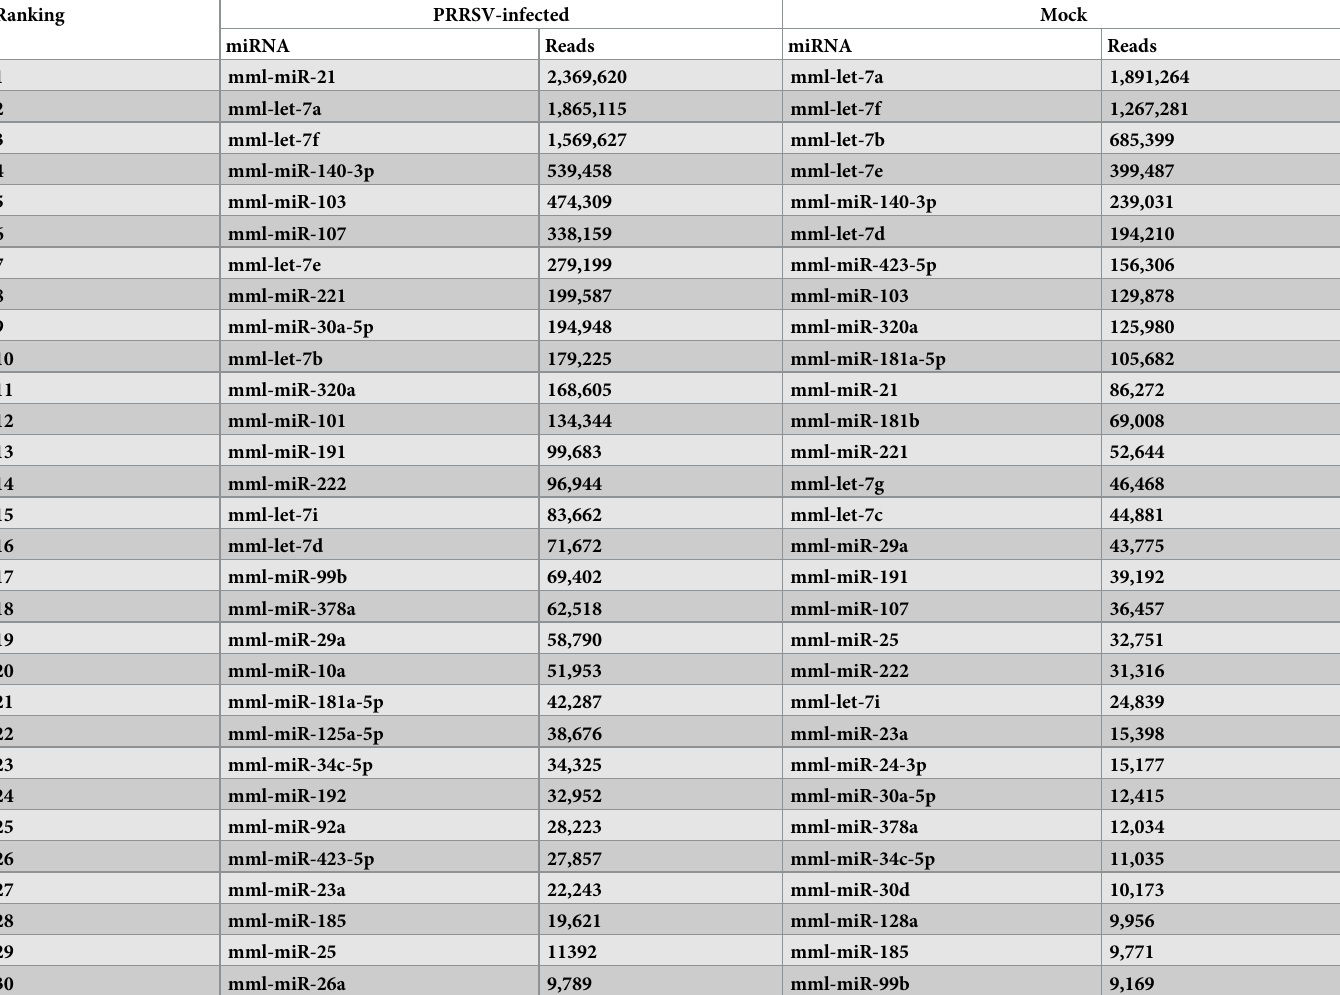
Table 4. The thirty most commonly sequenced miRNAs in PRRSV-infected and uninfected MARC-145 cells.